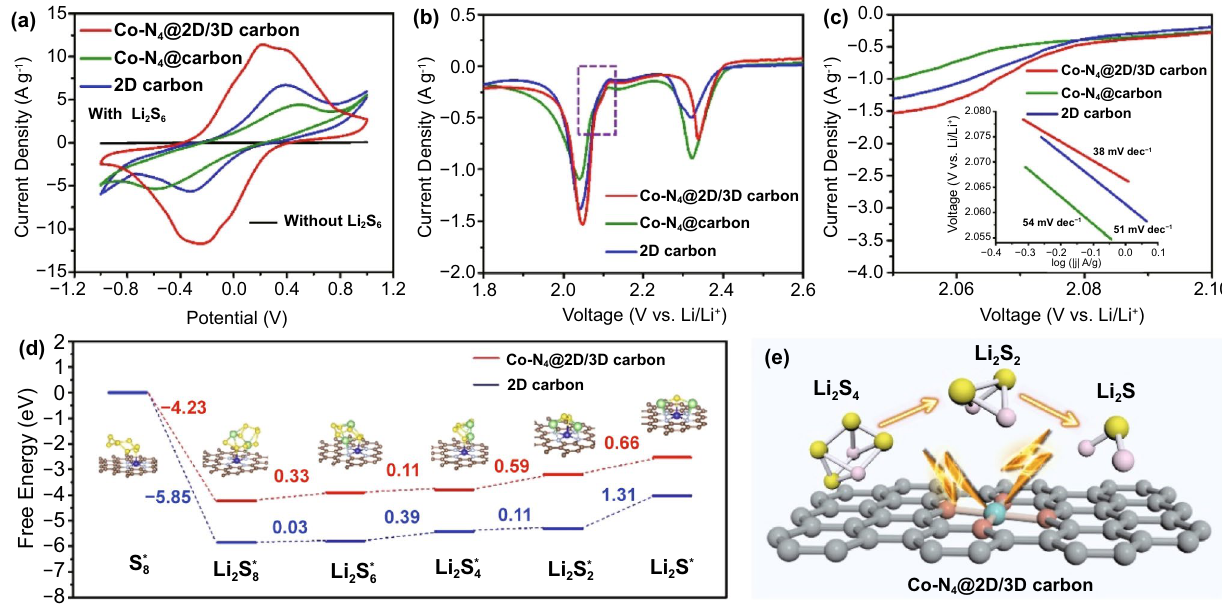
Fig. 5 a CV curves of symmetric cells from − 1 to 1 V and b LSV curves between 1.7 and 2.8 V at a scan rate of 0.1 mV s −1 with the